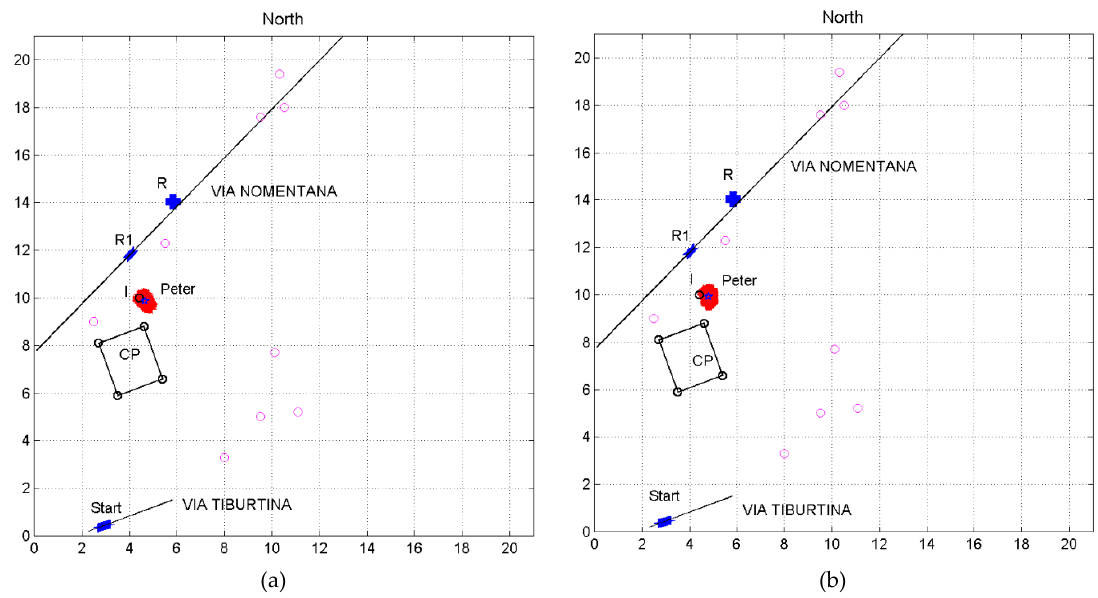
Figure 11. Maps with the results of the simulation (5000 runs). ( a ) Left panel : Most southern angular range in step (5). The blue crosses give the starting point of Peter’s walk in Via Tiburtina; the blue crosses on Via Nomentana give Peter’s arrival point R1; R is where Peter disappears for the downhill path; the red “cloud” of points give the alleged Peter’s first burial site, i.e., the site where he hit the stick to ground (“stick point”). “I” stands for the Anonymous Hypogeum. The barycenter of the red area has average coordinates (4.67 ± 0.12; 9.85 ± 0.14) , to be compared with those of I ( 4.4; 10.0) , of Figure 10. The average distance from “I” is 61 ± 27 m. ( b ) Right panel : Most northern angular range in step (5). The barycenter of the red area has average coordinates (4.80 ± 0.09; 9.90 ± 0.16) , to be compared with those of I ( 4.4; 10.0) , of Figure 10. The average distance from “I” is 83 ± 19 m.